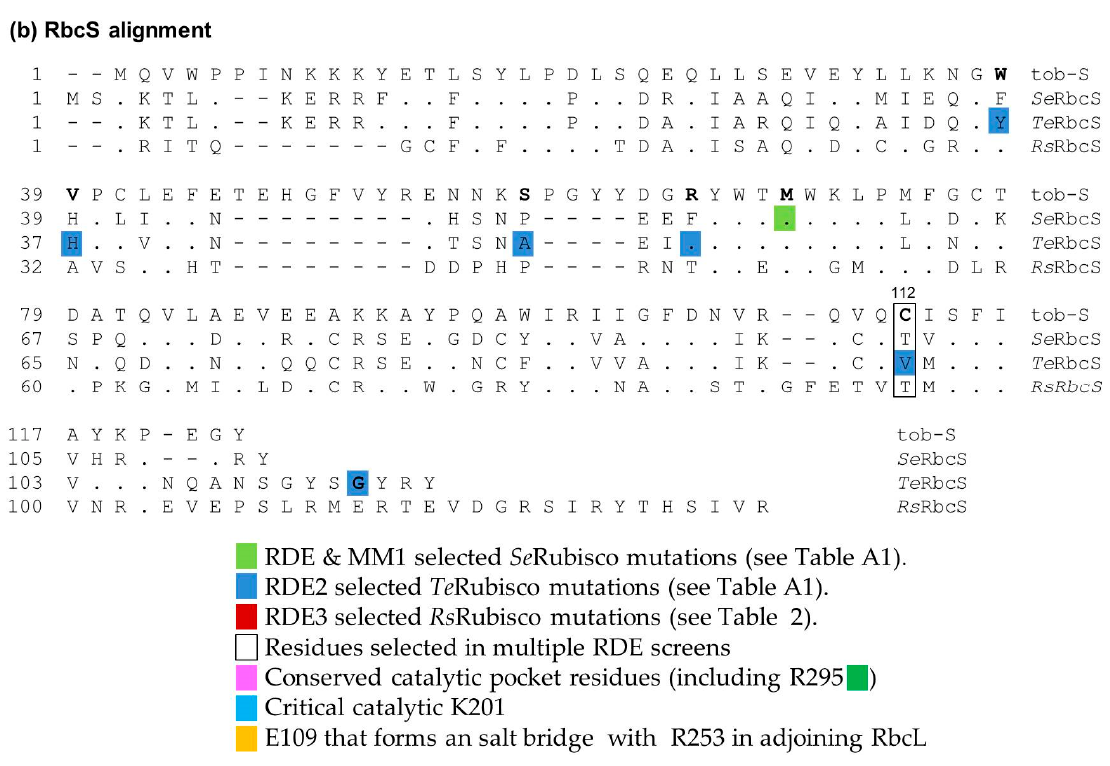
Figure A1. Alignments of (a) RbcL and (b) RbcS for Rubisco from Nicotiana tabacum (tob-L, Z00044; tob-S, XP_016440853), Synehcococcus elongatus PCC6301 ( Se RbcL, P00880.2; Se RbcS P04716), Thermosynehcococcus elongatus BP1 ( Te RbcL, NP_682296.1; Te RbcS NP_682294.1) and Rhodobacter spharoides ( Rs RbcL, WP_002721829.1; Rs RbcS WP_002721826.1). The first 39 amino acids of the altered codon modified (cm) Rs RbcL N-terminus coded in pYZRsLS are shown in blue text. Sequences were Clustal W-aligned, with only residues differing from the tob sequences shown. Dashes were included to improve the alignment of any missing residues. Amino acid numbering is relative to tob-L and tob-S. Coloring is as indicated in the legend under panel (b).